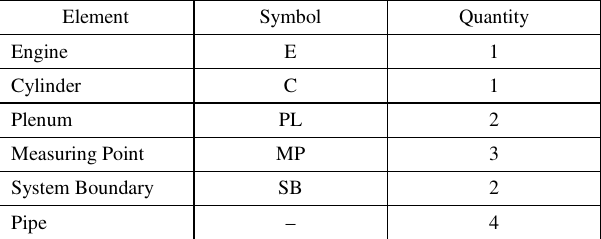
Table 1. Elements used to create an OP configuration in AVL BOOST